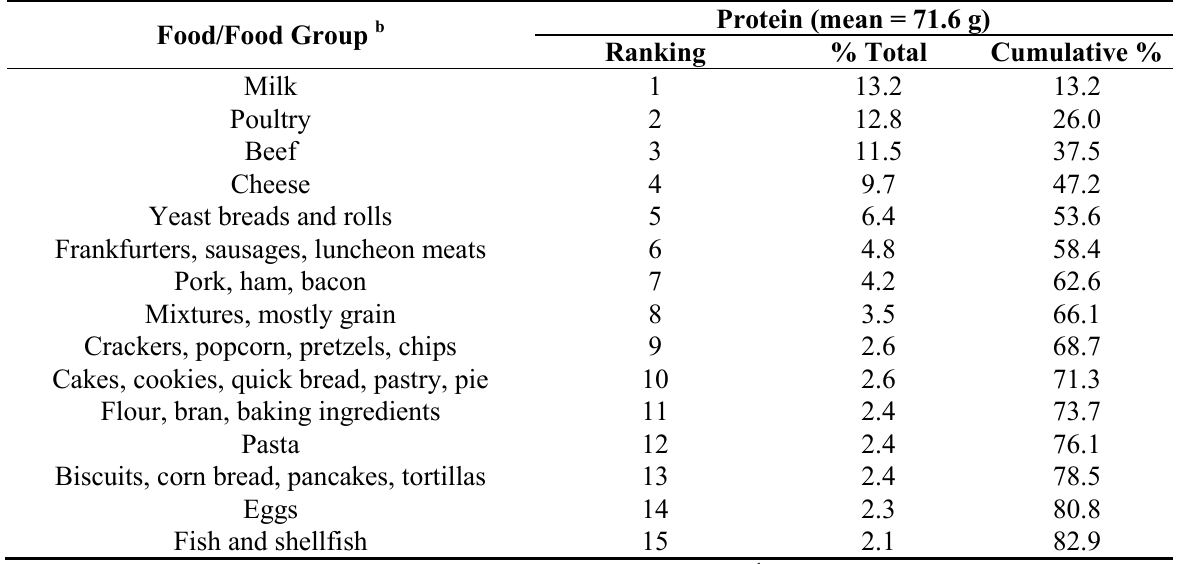
NHANES 2003–2006) a